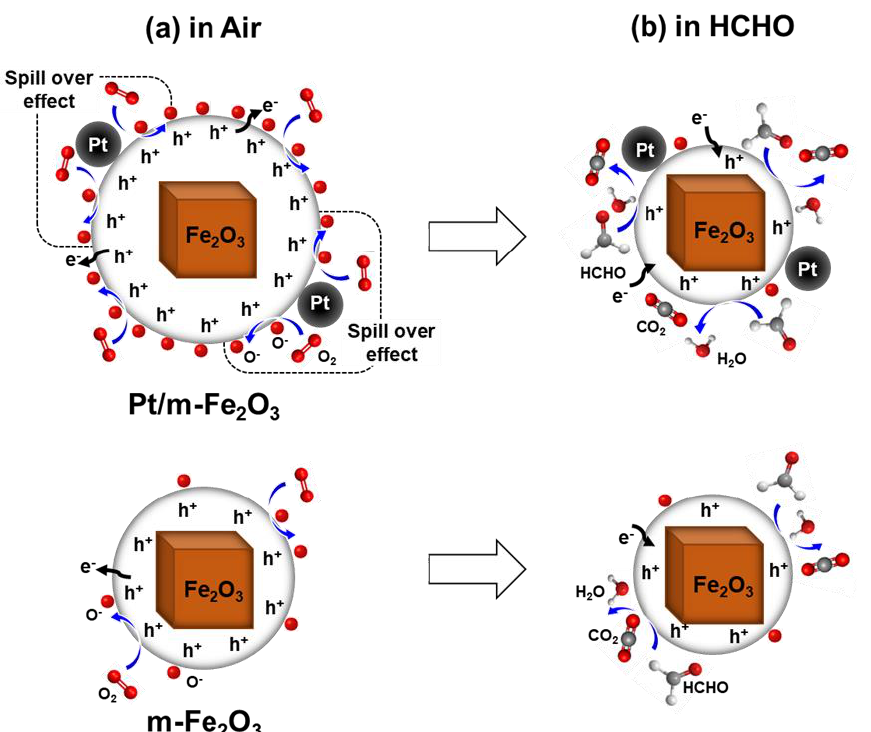
Figure 6. Schematic of gas-sensing mechanism for m-Fe 2 O 3 and Pt/m-Fe 2 O 3 ( a ) in air and ( b ) in HCHO conditions.